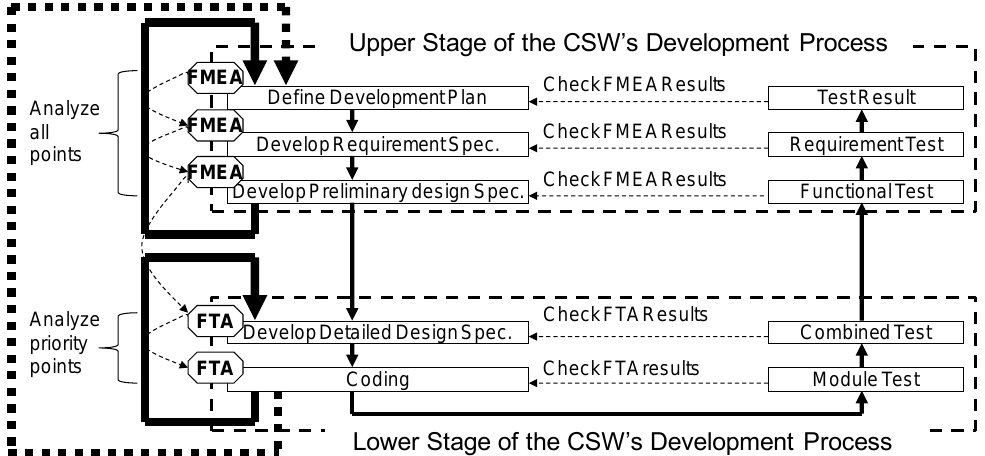
Figure 1. The control software (CSW) ’ s development process.